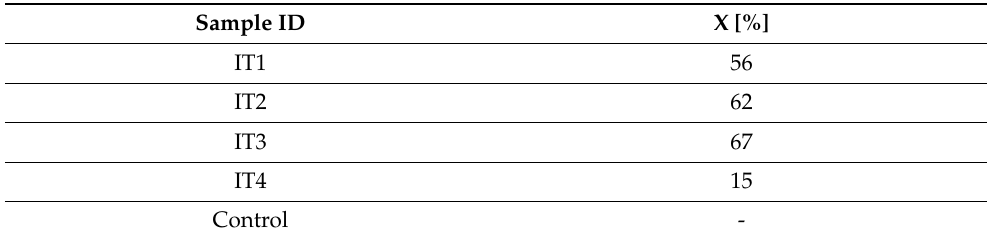
Table 5. Amorphous substance content in the case of the retrieved and control samples characterized based on FTIR